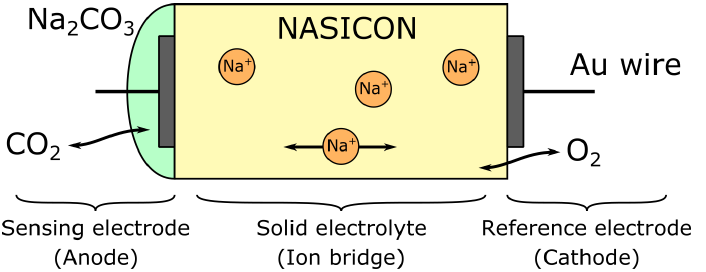
Figure 9. Outline schematic of a potentiometric CO 2 sensor as described by Maruyama et al. [210]. The NASICON sandwich with one end covered in sodium carbonate makes an electrochemical cell, the electromotive force of which yields pCO 2